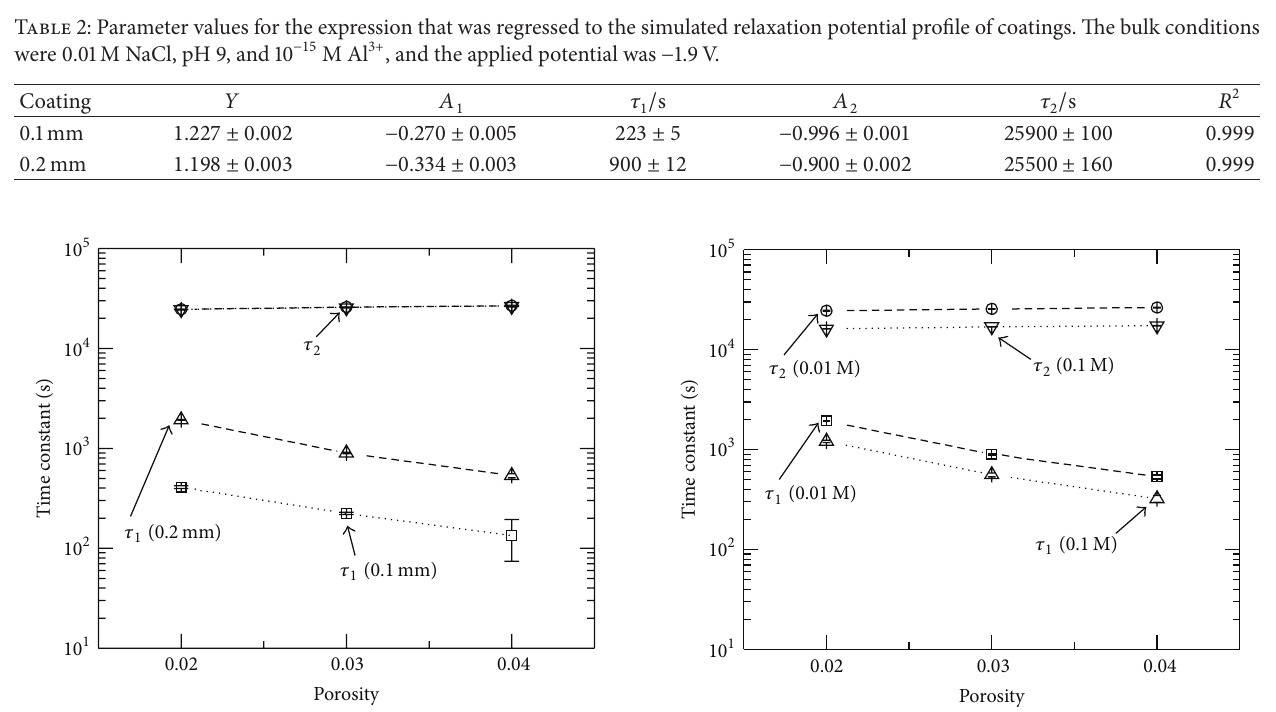
thick. The regressed time constants 𝜏 1 and 𝜏 2 are shown